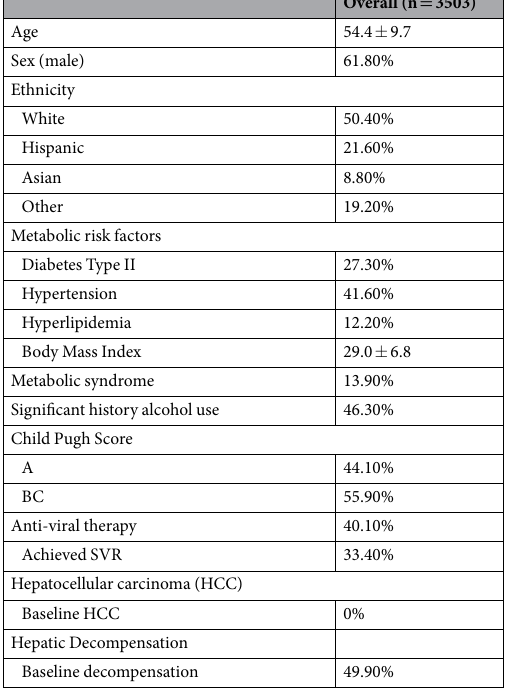
Table 1. Baseline clinical characteristics for 3503 patients with HCV cirrhosis. Abbreviations: SVR, sustained virilogic response; HCC, hepatocellular